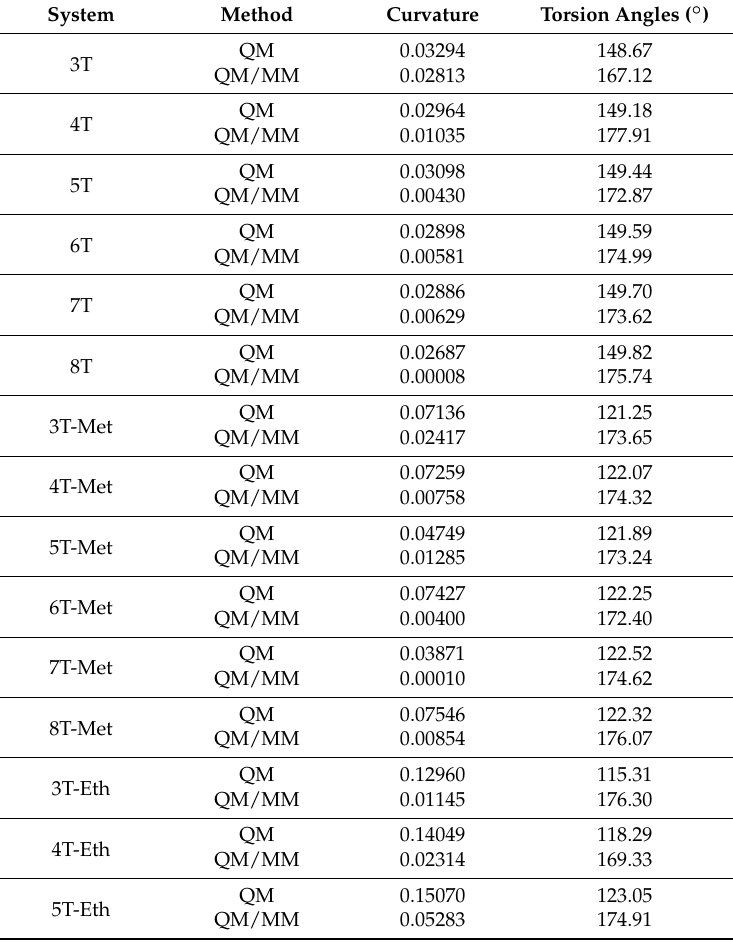
Table 1. The torsion angles between the neighboring thiophene rings and the degrees of curvature.